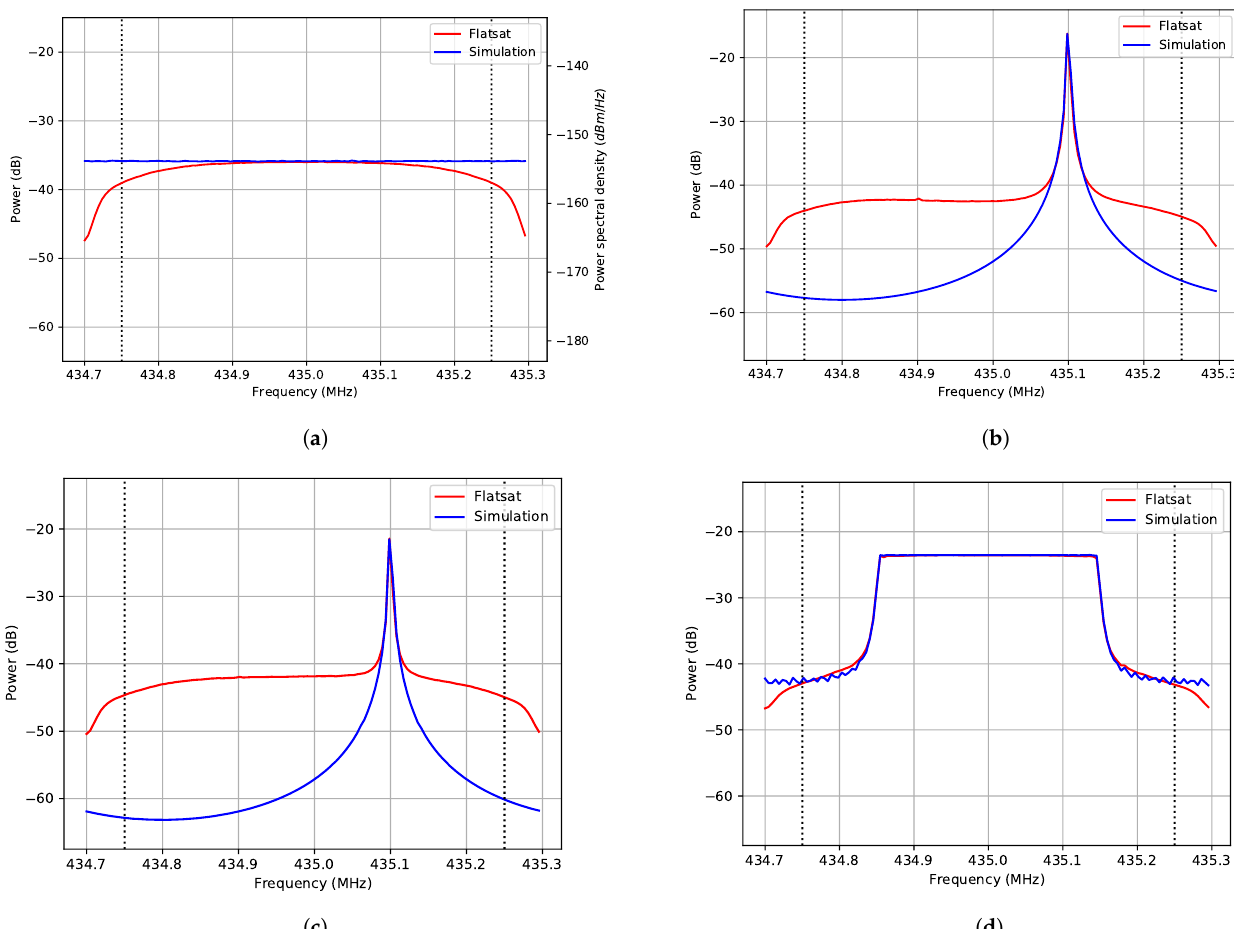
Figure 3. Test signal comparison of spectrum of average power in simulations (blue curves) and the median of 10 measure- ments with the flatsat (red curves). Black dotted lines indicate the 3 dB bandwidth of the receive filter. ( a ) AWGN (Additive White Gaussian Noise). ( b ) Complex CW (Continuous Wave) transmitted. ( c ) Complex pulse (5 s long and period 16.67 ms) transmitted. ( d ) Complex chirp (300 kHz wide, 5 s long, and period 16.67 ms)